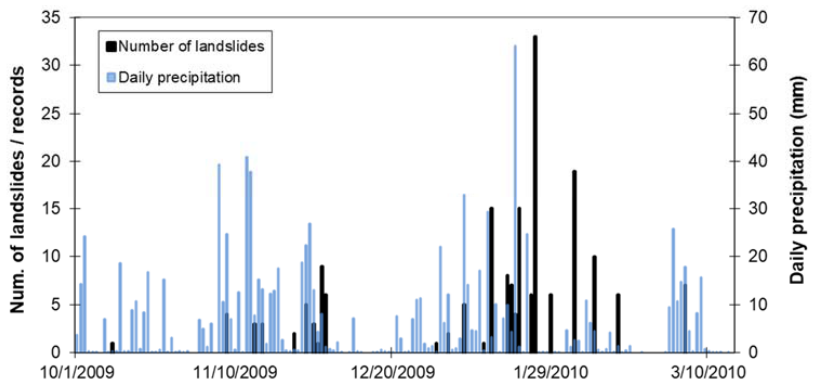
Figure 4. Daily precipitation and landslides recorded during the most critical part of the hydrological year of 2009/10 in the GPR basin.